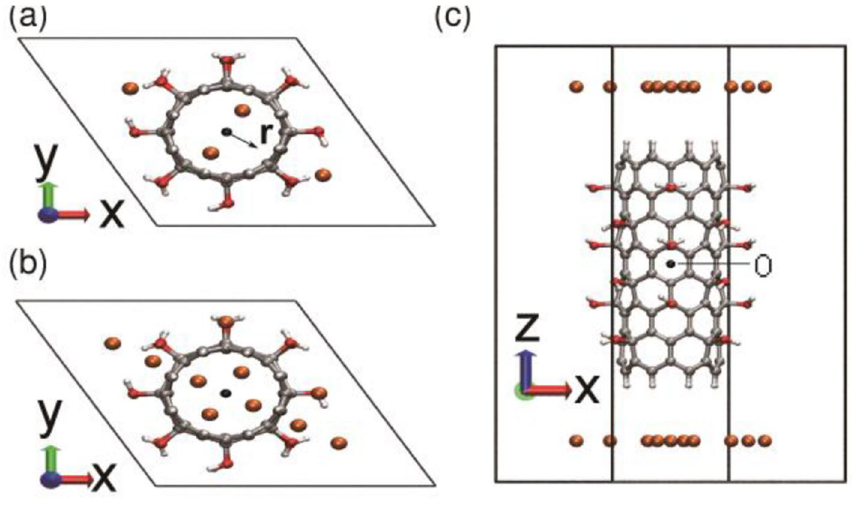
Figure 1. Initial conformation of the unit cell for ab initio MD simulations. The lithium and hydrogen atoms are shown in orange and light gray, respectively; the carbon atoms are displayed in dark gray; and the oxygen atoms are in red. ( a ) and ( b ) are the –OH functionalized CNT with four and ten lithium atoms placed upon each end of the CNT, respectively. ( a , b ) Top view; ( c ) side view. The symbol O indicates the origin of the coordinates. The radial distance between the lithium atoms from the central axis of the nanotube is denoted by the symbol r used together with the black arrow. The pictures are generated by VMD 1.8.3 software. URL link: http:// www. ks. uiuc. edu/ Resea rch/